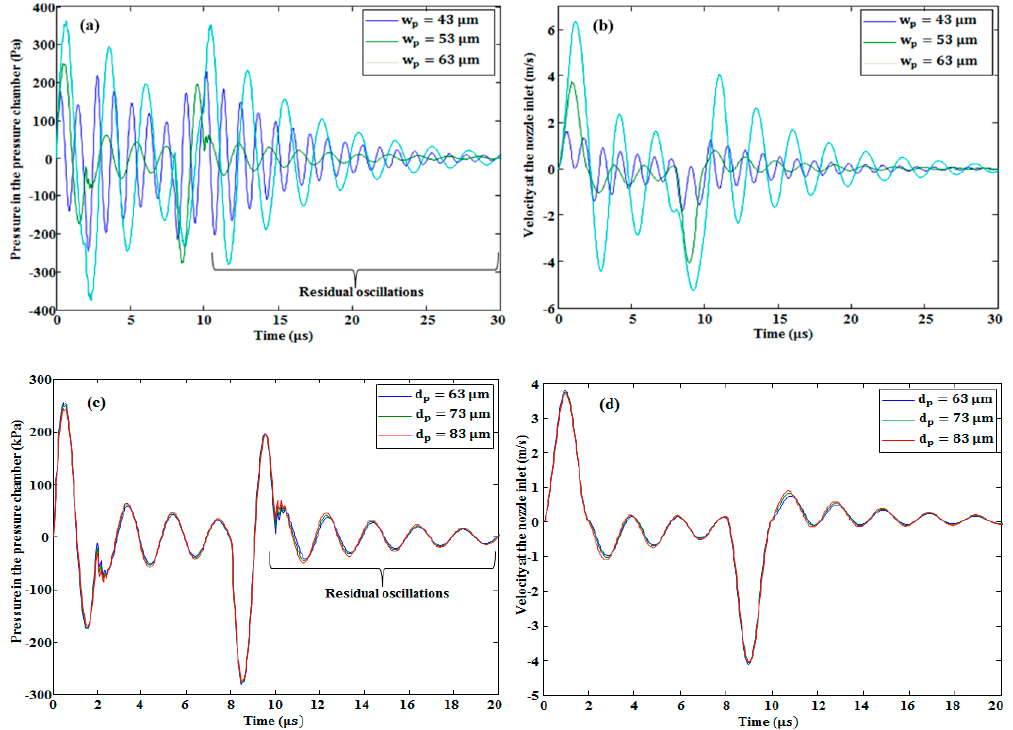
Figure 12. Effect of pressure chamber width variation on ( a ) pressure in the pressure chamber and ( b ) velocity at the nozzle inlet. Effect of pressure chamber width variation on ( c ) pressure and ( d ) velocity.